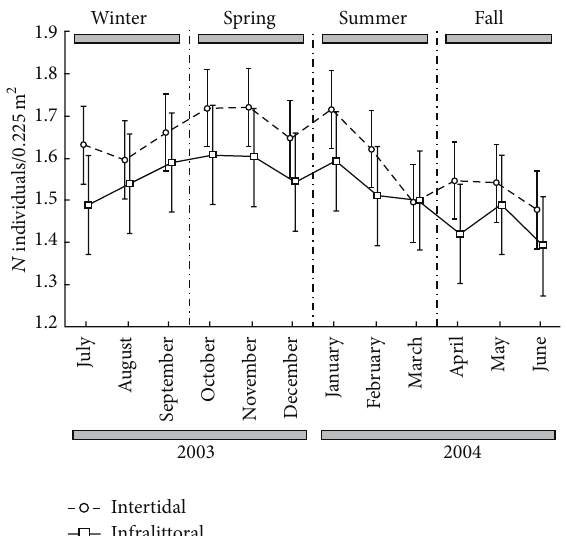
Figure 4: Monthly variation of the mean density of Monokalli- apseudes schubarti per 0.225 m 2 (in this case transformed to the fourth root), in intertidal and subtidal of Saco da Fazenda, during the period from July 2003 to June 2004 (mean ± standard error).